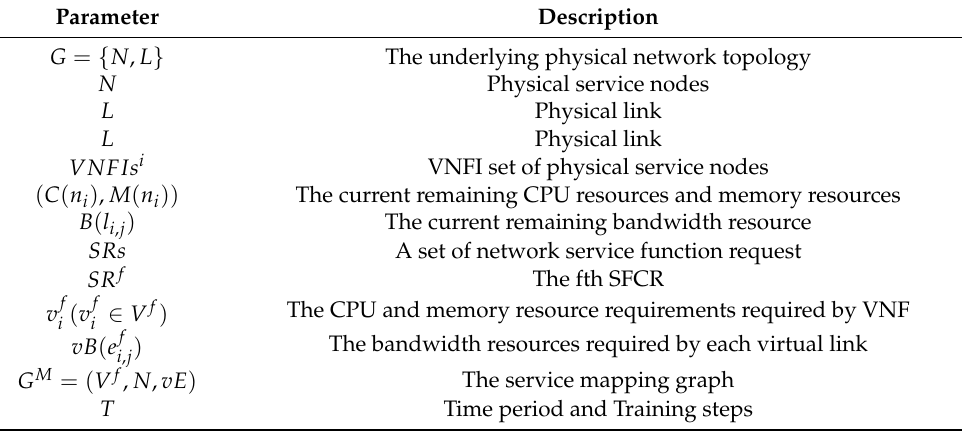
Table 2. List of all the